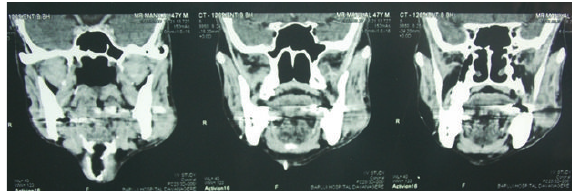
Figure 3: CT scan reveals cystic lesion in masseteric space involving the ramus of the left mandible with lytic and sclerotic